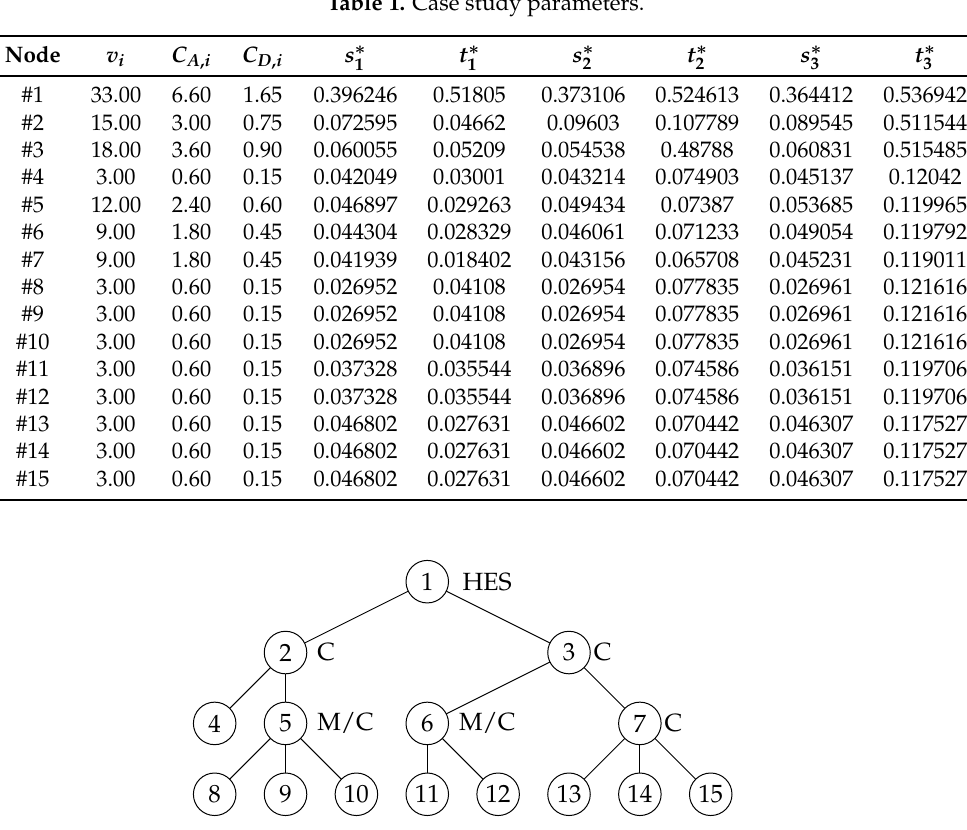
Table 1. Case study parameters.